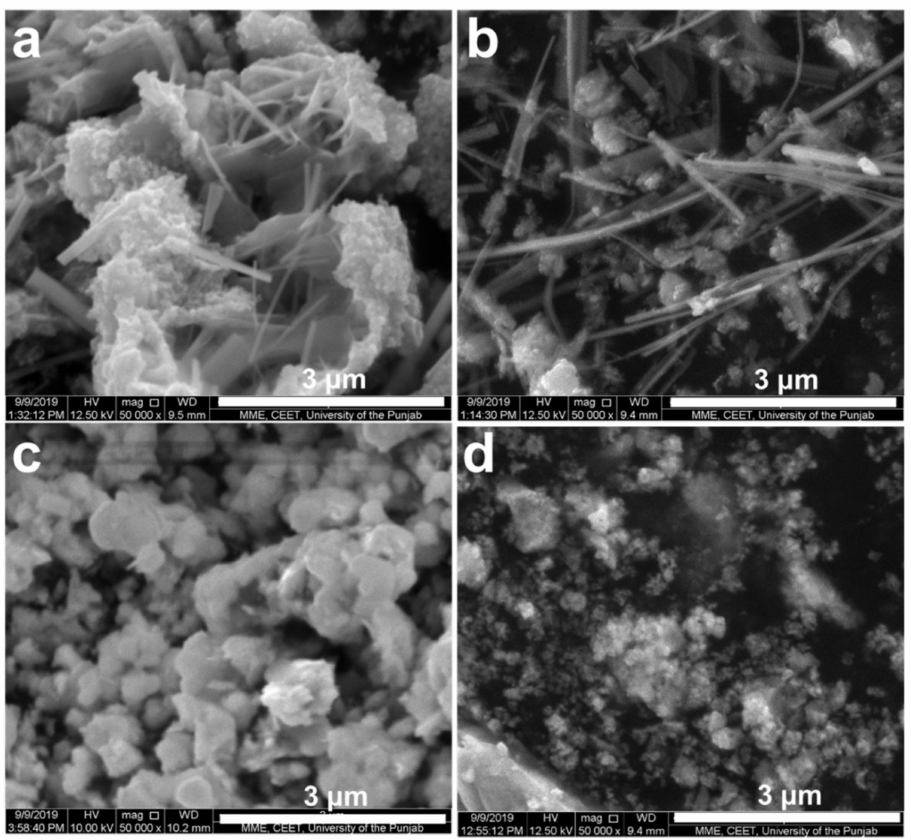
Figure 5. SEM images of ( a ) BFO-C, ( b ) BFO-S, ( c ) BFO-L, and ( d ) BFO-M nanoparticles.